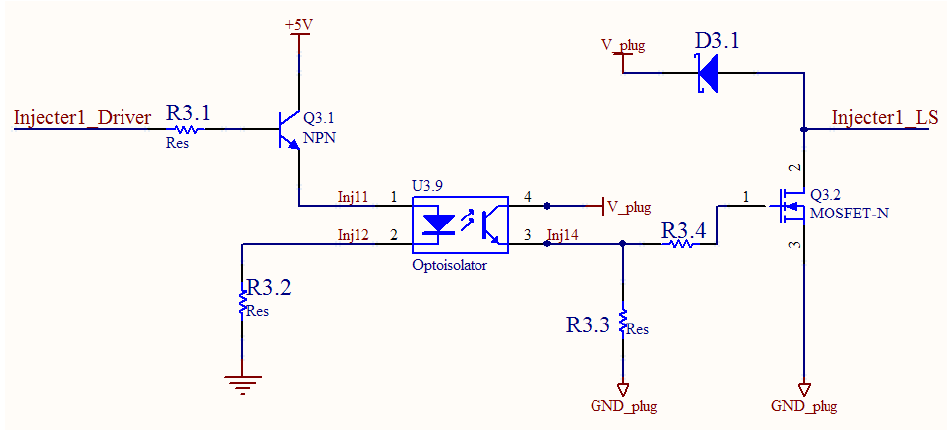
Figure 4. Supply rejection ratio.